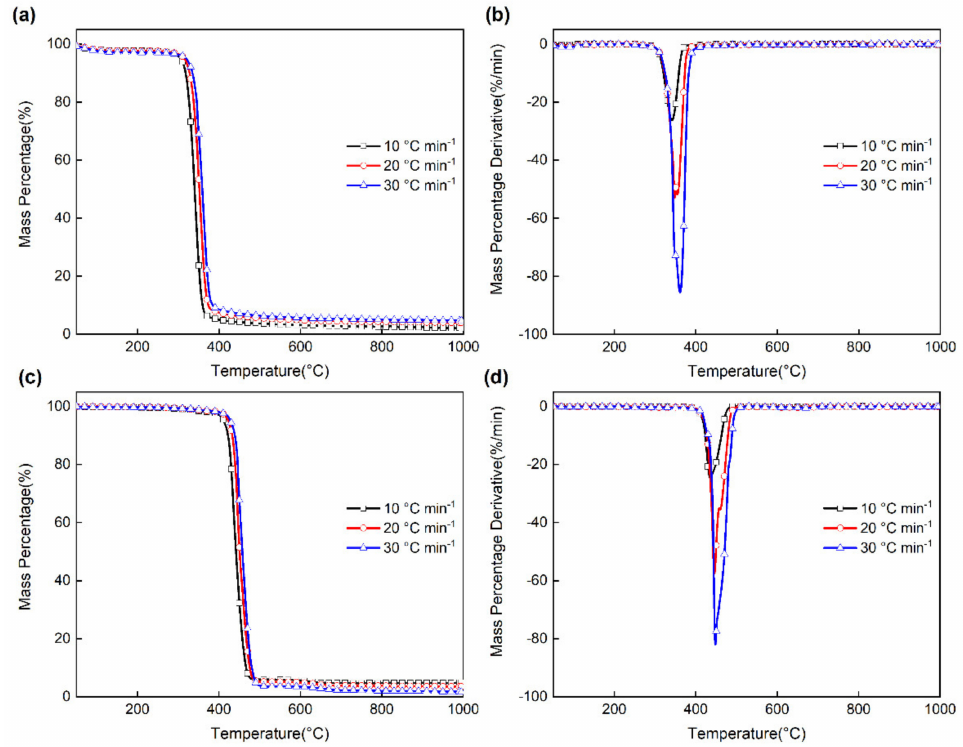
Figure 1. TG and DTG curves of MC ( a , b ) and SBS ( c , d ) at heating rates of 10, 20, and 30 ◦ C min − 1 . MC is a typical biomass model compound. For general biomass, pyrolysis can be divided into three main stages: moisture drying, main degradation of unstable polymers, and continuous residue slow decomposition [40,41]. Figure 1 shows that the pyrolysis of MC is divided into three stages. The first stage occurs from room temperature to about 200 ◦ C. At this stage, the moisture in the MC is dried. Correspondingly, a slight weight loss can be seen in the TG curve, but the slight weight change is not enough to make the DTG curve produce obvious peaks. Stage 2 is the most important pyrolysis process of MC, which mainly occurred at 200–430 ◦ C. The organic components of the main body were decomposed in this process. The mass change reached about 90% at all three heating rates, corresponding to an obvious peak in the DTG curve. The peak value increased with the increasing heating rate. The corresponding temperatures were 342.3, 348.0, and 360.7 ◦ C, respectively. Zhou et al. [42] studied the pyrolysis of MC at the heating rate of 10 ◦ C min − 1 and reported that the peak happened at 344.2 ◦ C. This is consistent with the above result, due to the structure of MC being without any branches [43]. The third stage occurred in the subsequent temperature range. The mass reduction is caused by the decomposition of thermally stable residues. The mass change is small and there is no obvious fluctuation in the DTG